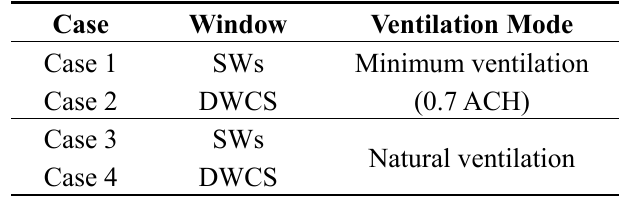
Figure 7. Residential unit modeling by ESP-r of ( a ) Model 1 (SWs) and ( b ) Model 2 (DWCS). Table 2. Simulation cases.